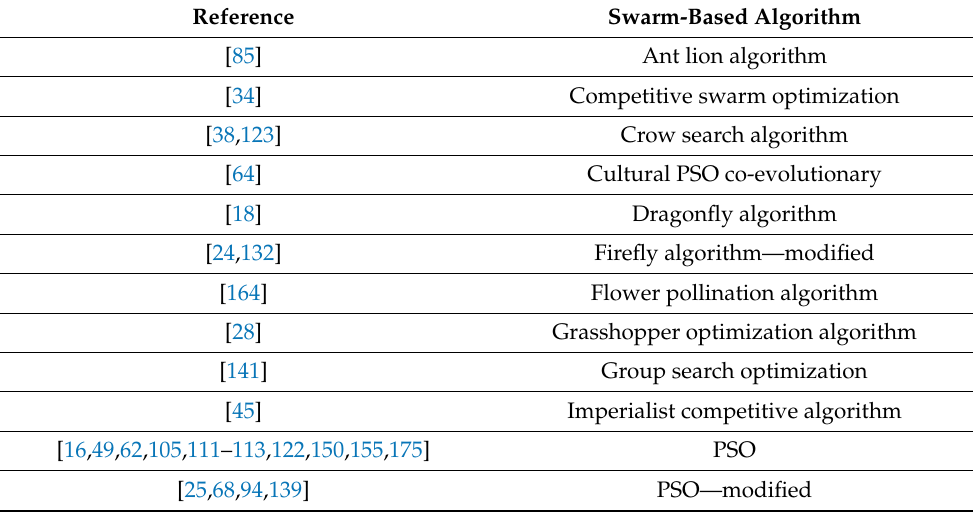
Table 9. Swarm-based metaheuristic algorithms employed in the DGS